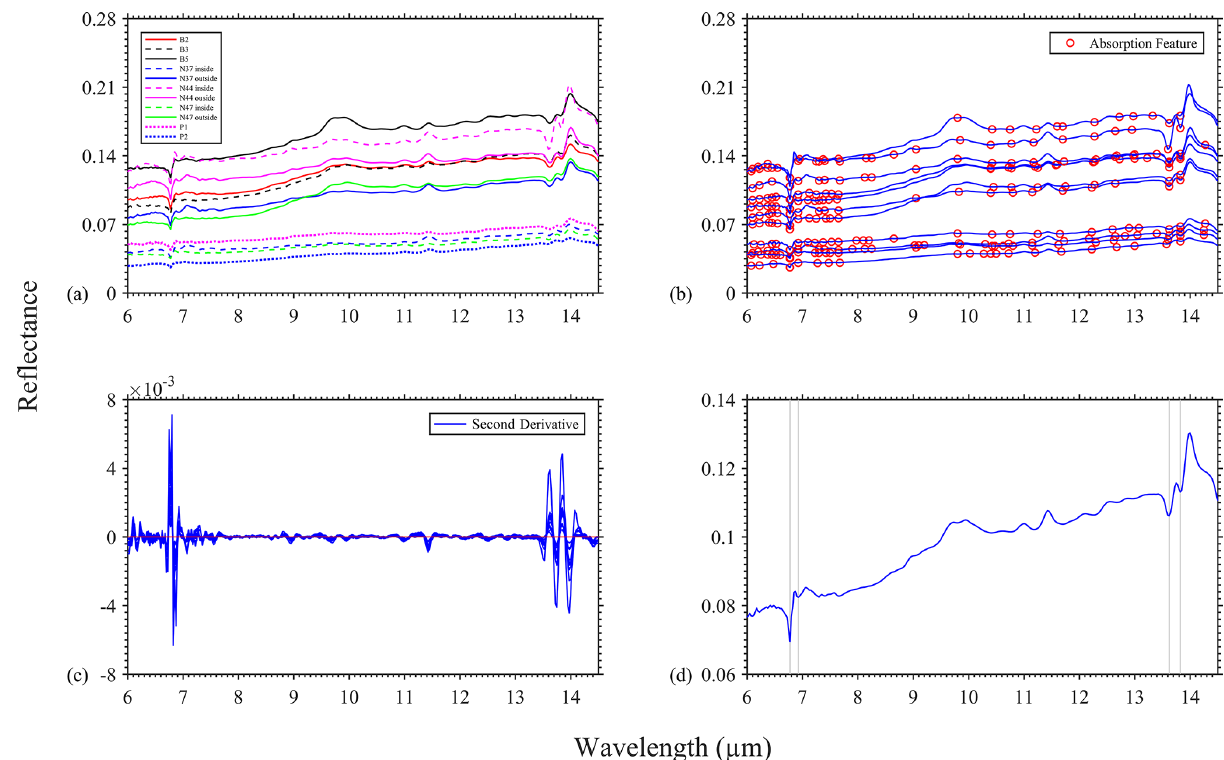
Figure 8. (a) Spectral reflectance of fragmented plastic objects found along the shorelines of Punta Mallil-Cuem, Detif and Punta Apabón on the Chiloé Archipelago, Chile; (b) absorption features automatically picked; (c) second-derivative spectra; and (d) an end-member signal with the proposed diagnostic absorption features highlighted by the vertical